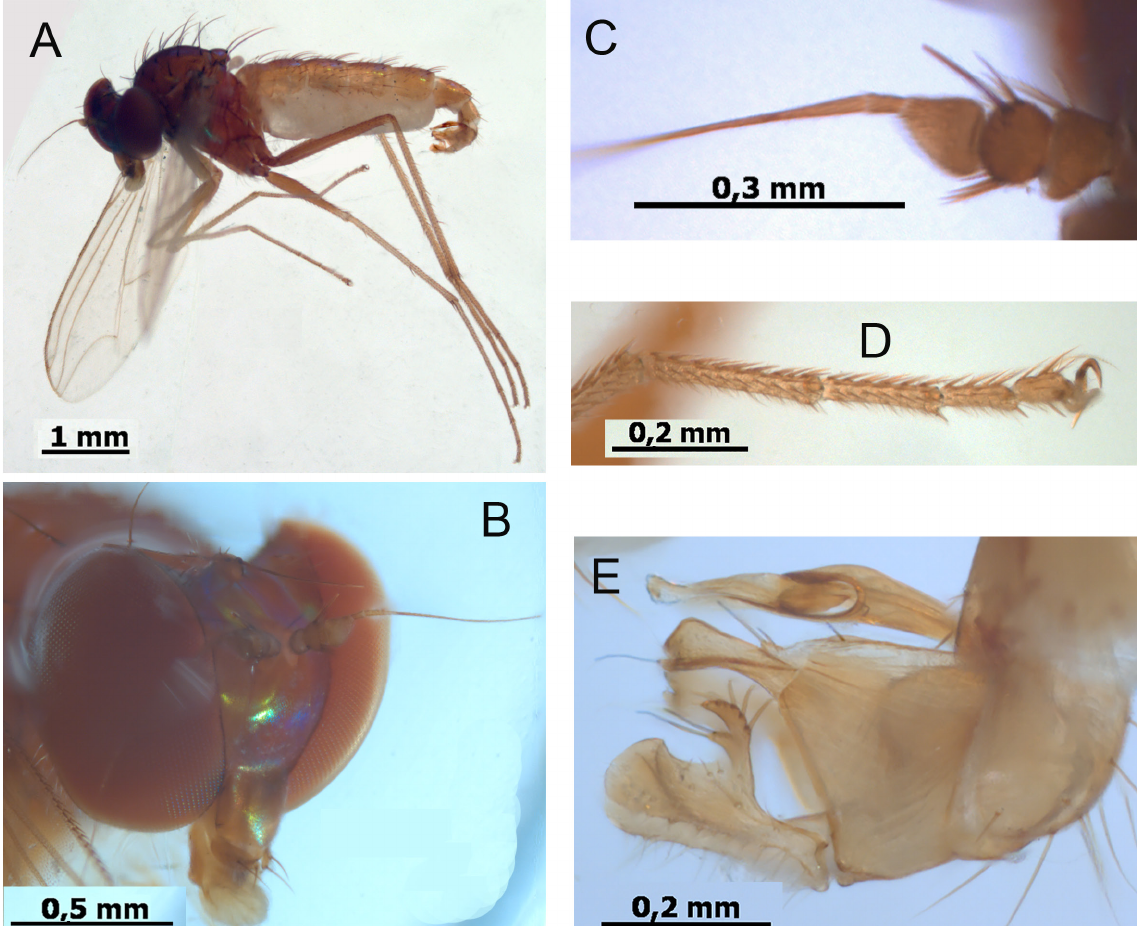
Fig. 2. Amblypsilopus gabonensis sp. nov., holotype, ♂ (ZIN). A . Habitus. B . Head. C . Antenna. D . Fore tarsomeres 2–5, lateral view. E . Hypopygium after maceration, left lateral